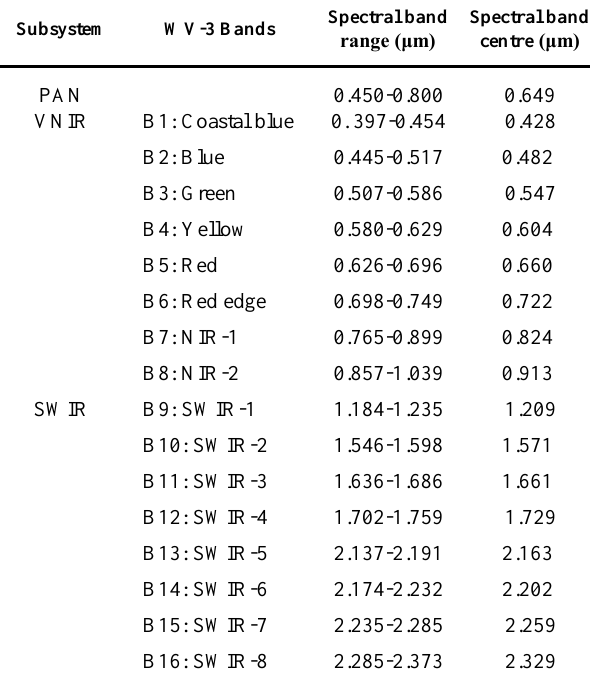
Table 1. Spectral resolution and band centres of WorldView-3 (WV-3) data (source: Digital